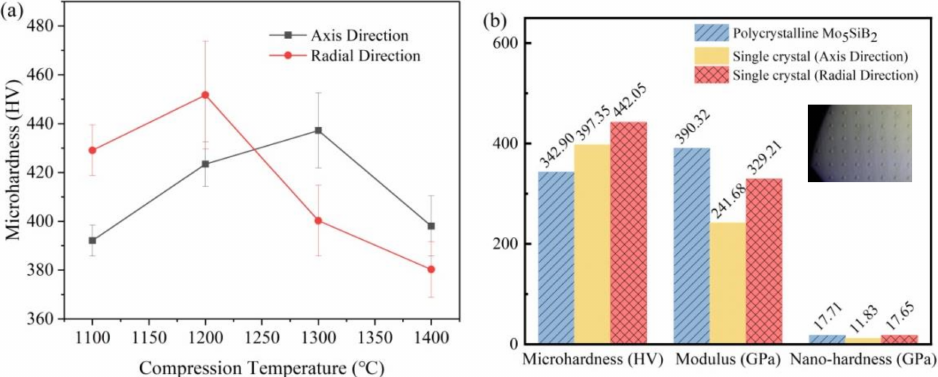
Figure 7. ( a ) Microhardness of Mo 5 SiB 2 single crystals after deformation at different temperatures at 0.01 s − 1 . ( b ) Nanoindentation test results of Mo 5 SiB 2